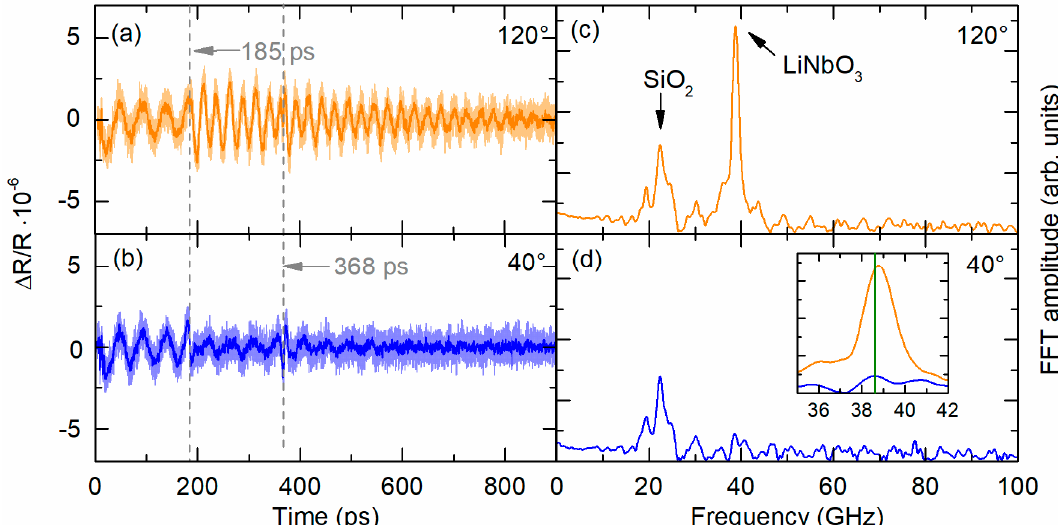
Figure 2. ( a , b ) Extracted oscillations for different polarization angles; ( c , d ) respective the Fast Fourier Transformations (FFTs). In the orange graphs, the superimposed response of LiNbO 3 and SiO 2 can be seen (data from the rotation angle of 120 ◦ of Figure 3). In the blue graphs, the part of LiNbO 3 is “turned off” (data from the rotation angle of 40 ◦ of Figure 3). The inset in ( d ) shows the shift of the LiNbO 3 frequency for the FFT at 120 ◦ and 40 ◦ . The green line is a guide to the eye to enable better visibility of the occurring frequency shift.